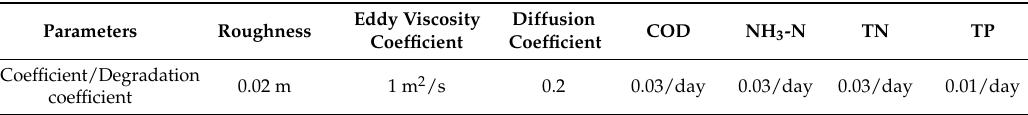
Table 5. The parameters of the water quality model.